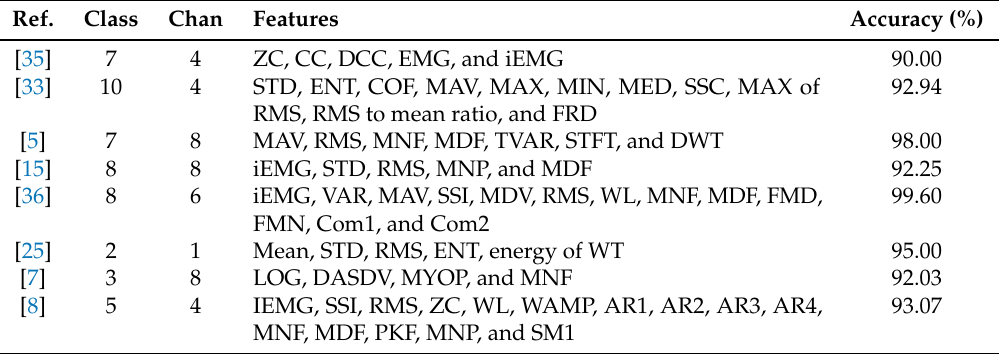
Table 7. EMG signals classification methods with features in two or more domains.